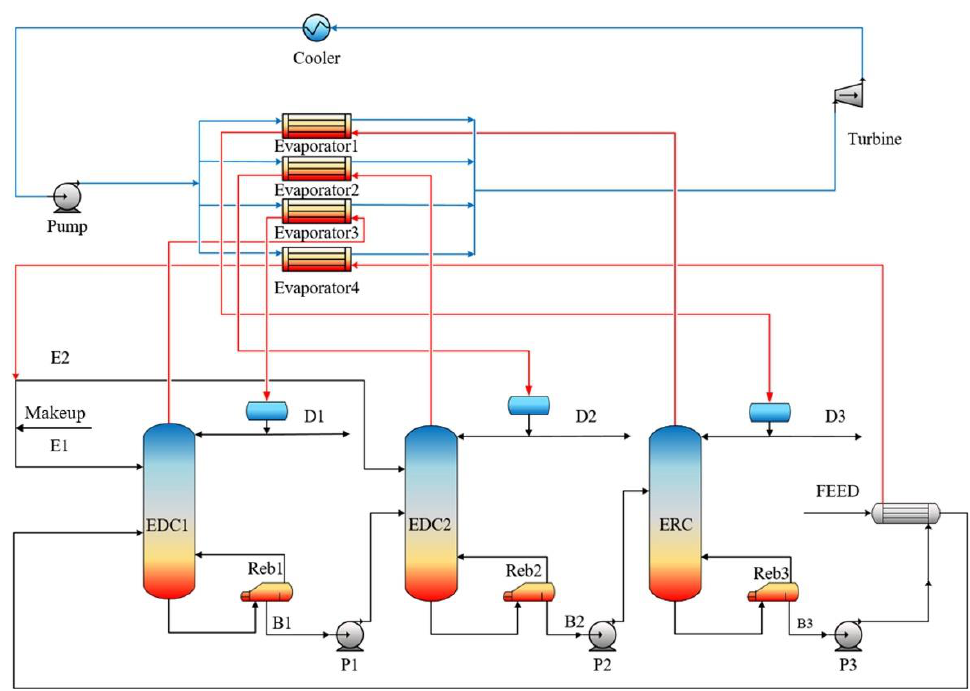
Figure 4. Improvement of ACN/EtOH/H 2 O separation using a four-parallel evaporator ORC system. Reproduced with permission from [25]. Copyright 2021, Elsevier.